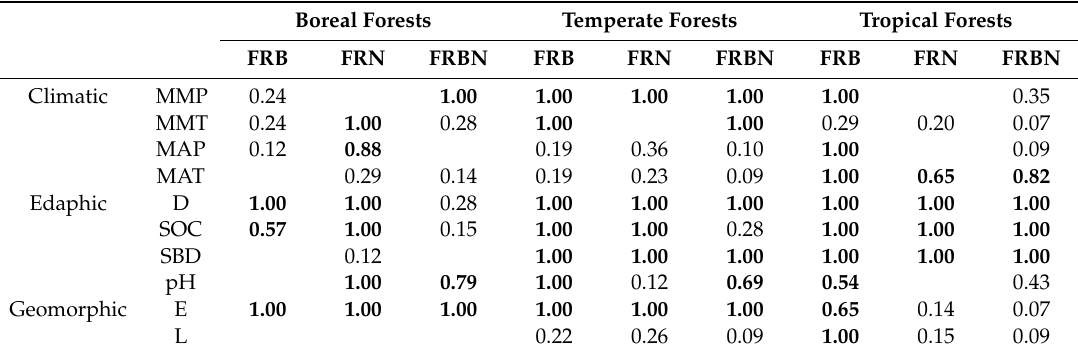
Table 3. Relative importance (expressed as Akaike weights) of explanatory variables of best models for monthly fine root biomass (FRB), necromass (FRN) and their biomass / necromass ratio (FRBN) of the di ff erent forest biomes. Bold values are greater than 0.50, representing important explanatory variables. The abbreviations of variables were provided in Table 2. Boreal Forests Temperate Forests Tropical Forests Climatic MMP